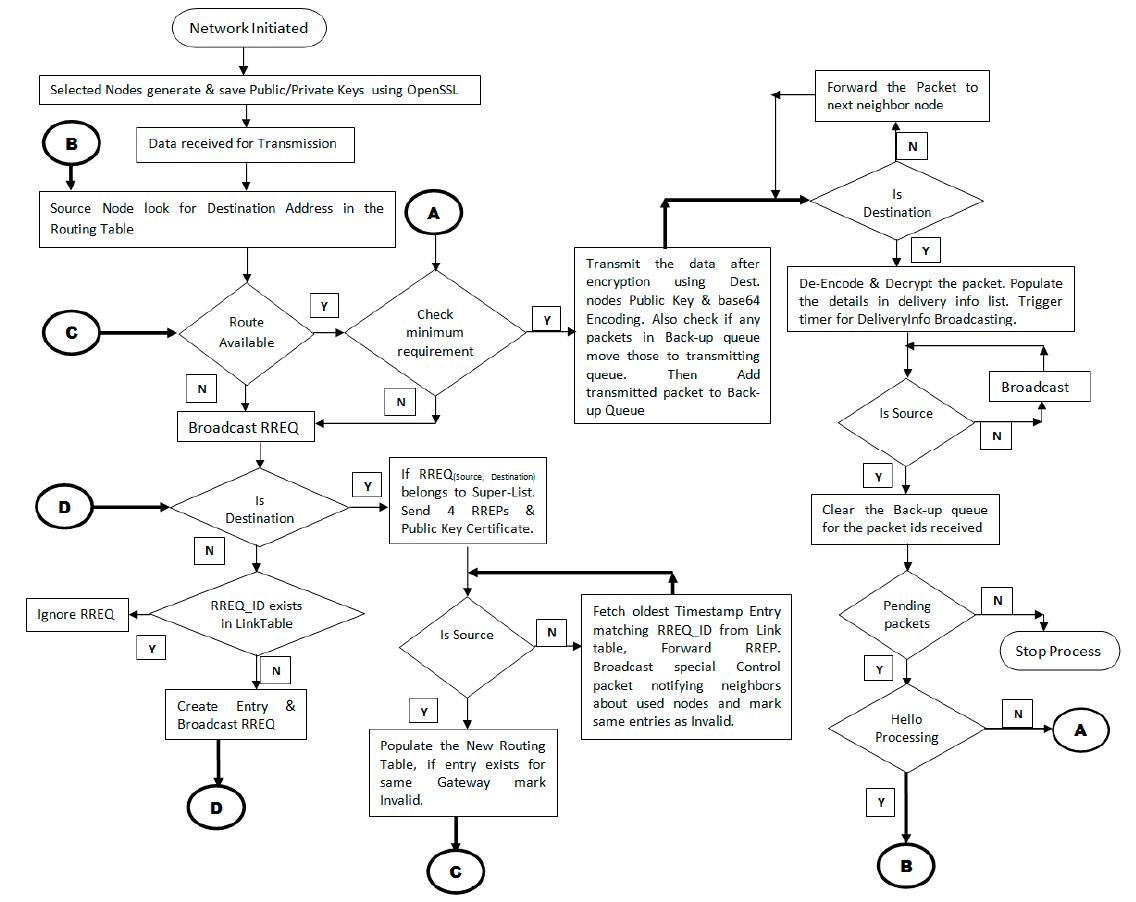
Figure 6. Flowchart for the ESTA